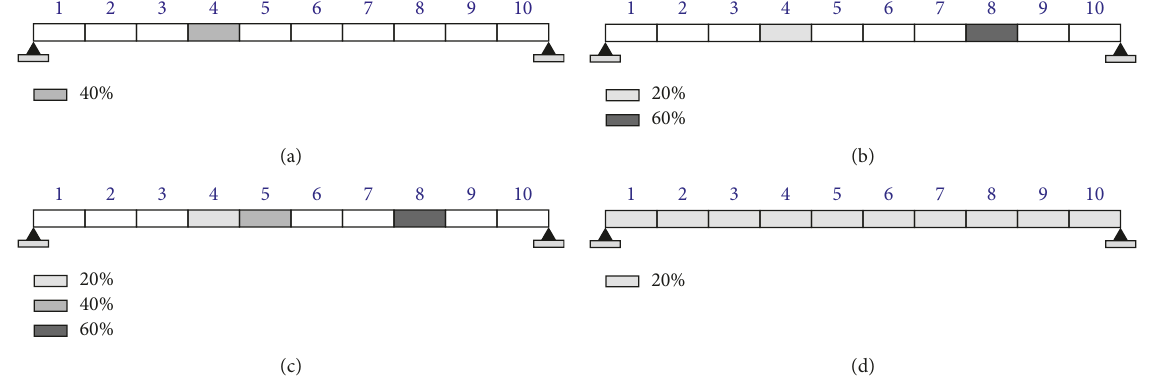
Figure 3: Beam example: the four different damage scenarios. (a) Scenario 1, (b) scenario 2, (c) scenario 3, and (d) scenario 4.